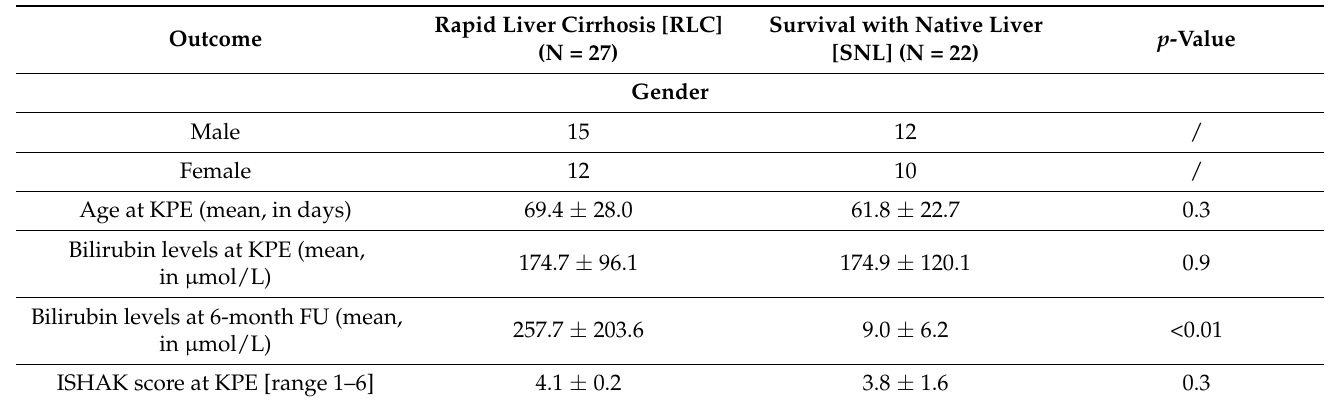
Table 1. Clinical parameters of the cohort.